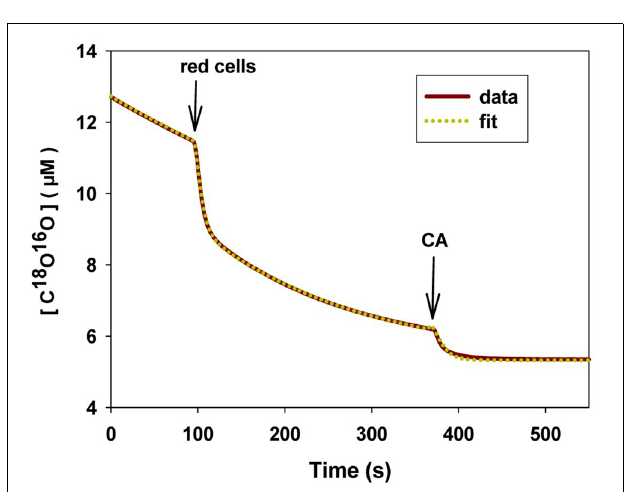
FIGURE 9 | Original mass spectrometric recording of an experiment with human red cells. The concentration of C 18 O 16 O is plotted vs. time. First arrow point of addition of red cells, second arrow point of addition of CA in excess to rapidly establish final isotopic equilibrium. Solid curve (red): mass spectrometric recording; dotted curve (yellow): calculated curve using and P HCO − . 37C. the best-fit values of P CO 2 3